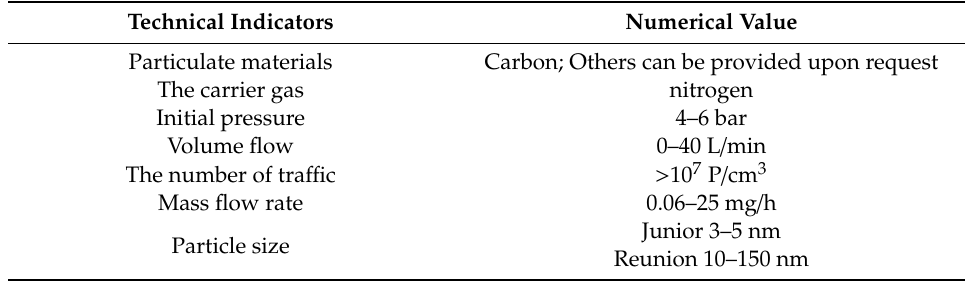
Table 1. Main technical parameters of dnp3000 particle